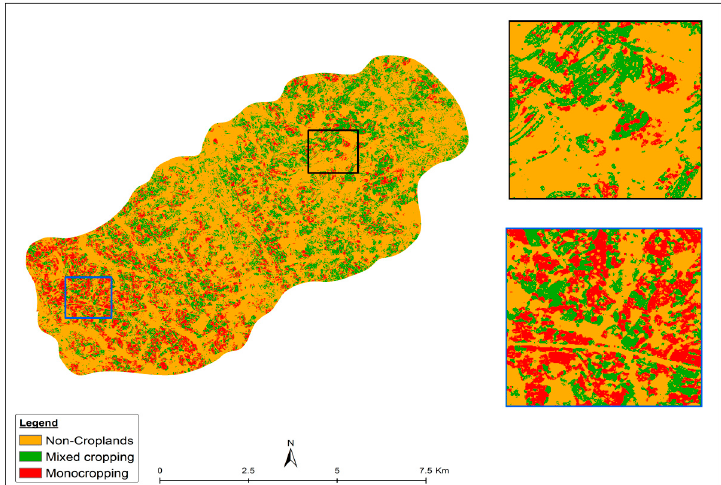
Figure 6. Maize cropping systems classification map obtained using the proposed classification scheme (Figure 2). The two inserts, as black and blue squares, illustrate two contrasting areas in terms of cropping systems.